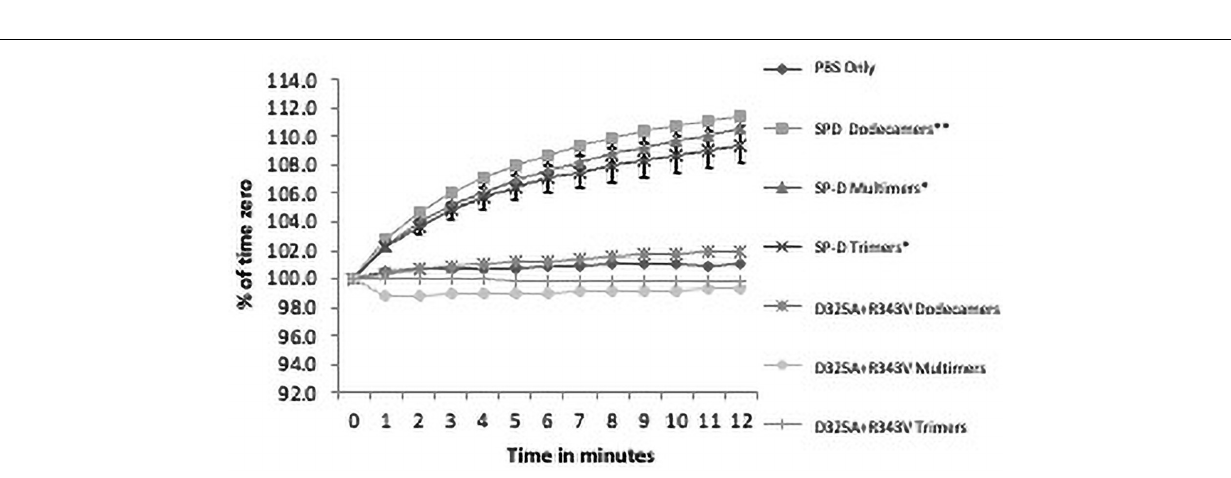
FIGURE 2 | Aggregation of Phil82 H3N2 virus by full-length wild-type or D325A + R343V molecules. Aggregation of the virus was assessed by light transmission, and 2 µ g/ml of SP-D molecules was added at time 0. Wild-type SP-D multimers, dodecamers, and trimers all caused significant viral aggregation ( ∗ p < 0.05 vs. control and ∗∗ p < 0.01 vs. control) (mean ± SEM; n = 5). The full-length multimers, dodecamers, and trimers containing the D325A + R343V mutations did not cause significant